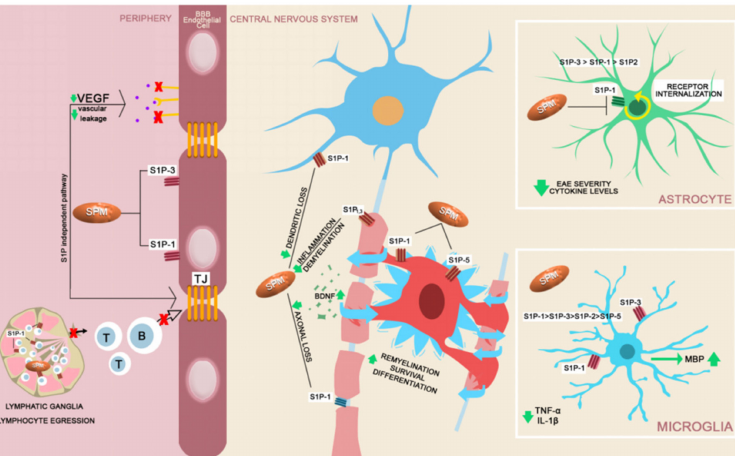
Figure 4. A brief schematic representation of fingolimod’s mechanism of action. In the periphery, fin- golimod (sphingosine phosphate receptor modulator–SPM) acts upon the sphingosine 1-phosphate receptors (S1P1, S1P2, S1P3, S1P4, S1P5) [101]. In the lymphatic ganglia, SPM antagonize the S1P1 expression and blocks the lymphocytic egression into the circulation (T and B). SPM blocks the expres- sion of S1P1 and S1P3 on the surface of the endothelial cells, reducing lymphocyte transmigration. Immune cell passage at the level of the BBB is reduced secondary VEGF reduced expression [109–112]. Inside the CNS the S1P receptors are expressed by the majority of neural cell lineages [113]. S1P1 and S1P5 modulation enhances oligodendrocyte function, survival, differentiation and secondarily boosts the remyelination [114,115]. Neuronal function is directly sustained by modulation of S1P1 and S1P3 receptors and by the up-regulation of BNDF expression, with neuroprotective effects [113,116]. The astrocytes, secondary to S1P1 modulation were proven to decrease EAE severity in murine studies and decrease the levels of proinflammatory cytokines [117,118]. fingolimod and SPM reduce proinflammatory cytokine production from microglia and increase the secretion of myelin basic protein (MBP) after a demyelinating event, promoting remyelination